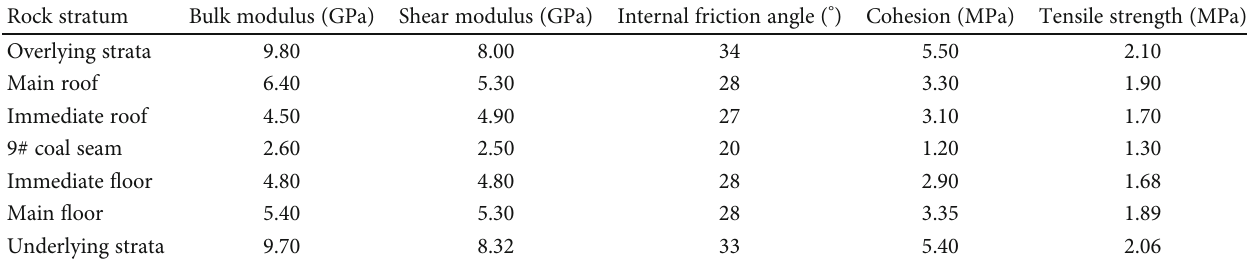
Table 7: Rock mechanics parameters.